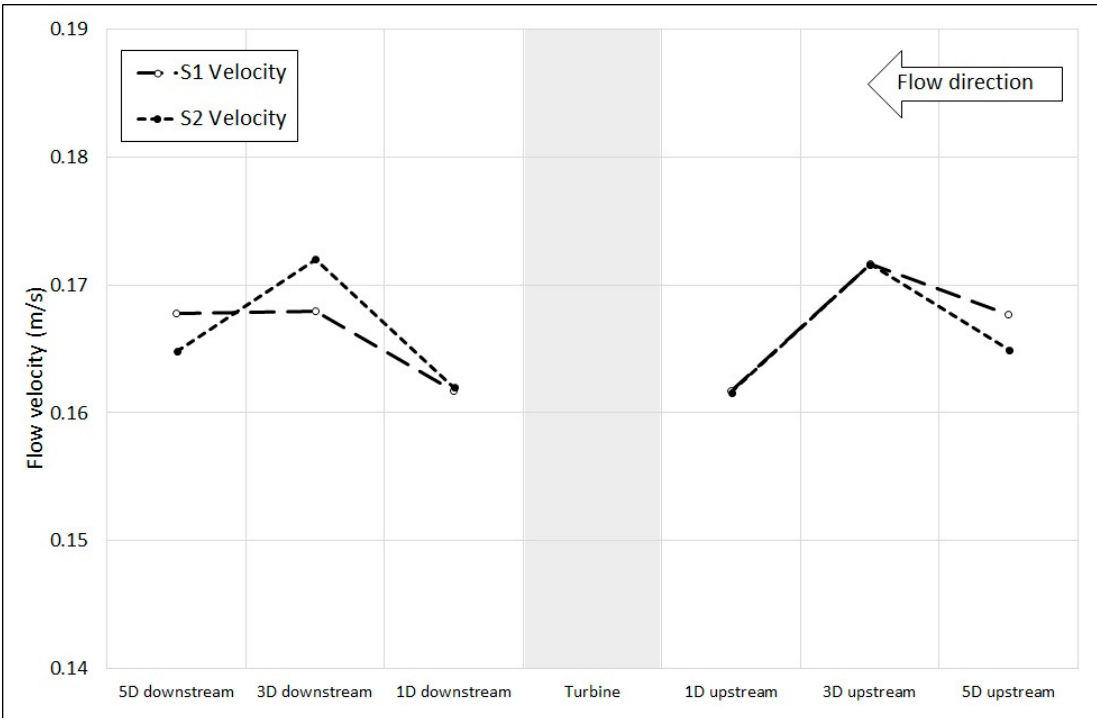
Figure 6. Mean hub height streamwise velocity recorded at 1D, 3D and 5D upstream and 1D, 3D and 5D downstream of turbine mounted on S1 and S2 support structures (4096 samples at 25 Hz per point).